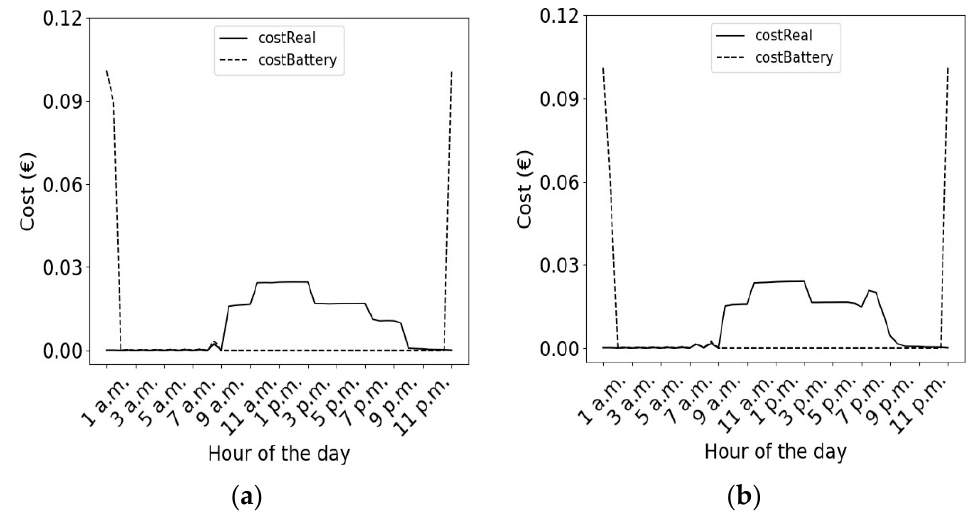
Figure 7. Variation of the electricity costs in a working day in the selected area of the building considering or not the installation of the battery. ( a ) Train/Dev sample division; ( b ) Test sample division.